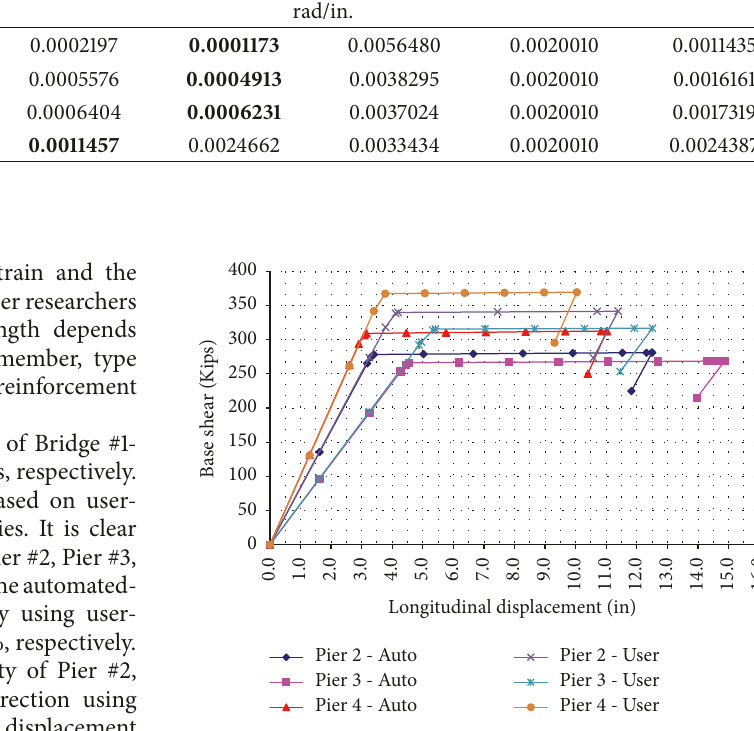
Figure 3: Longitudinal pushover capacity curve of Bridge #1-W.